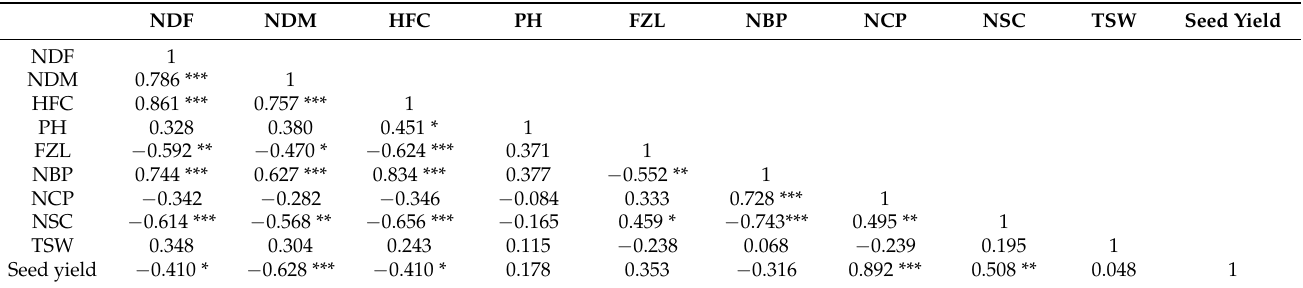
Table 6. Pearson’s correlation coefficients among the traits